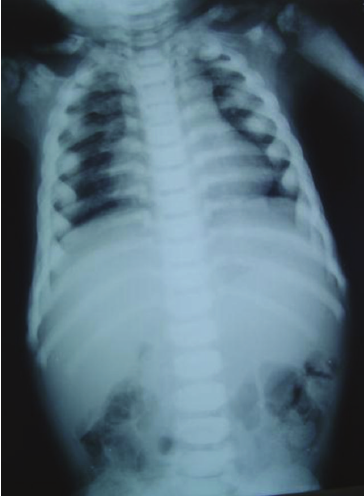
Figure 3: Chest radiograph showing long and narrow thorax (barrel-shaped chest) with anterior compression.